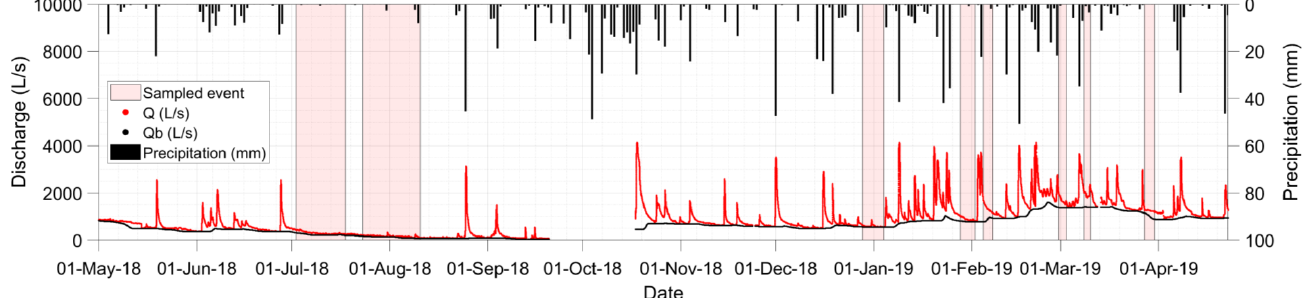
Figure 14. Relation between precipitation and discharge. The figure shows that there is no significant delay between rainfall and surface runoff. Additionally, during the sampled events, no significant rainfall was observed, indicating the absence of a surface runoff component in the sampled water.